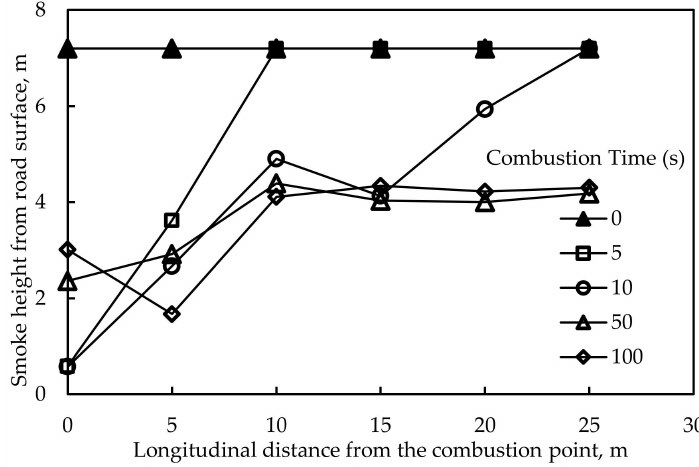
Figure 9. Smoke height distribution along the longitudinal direction (without fire